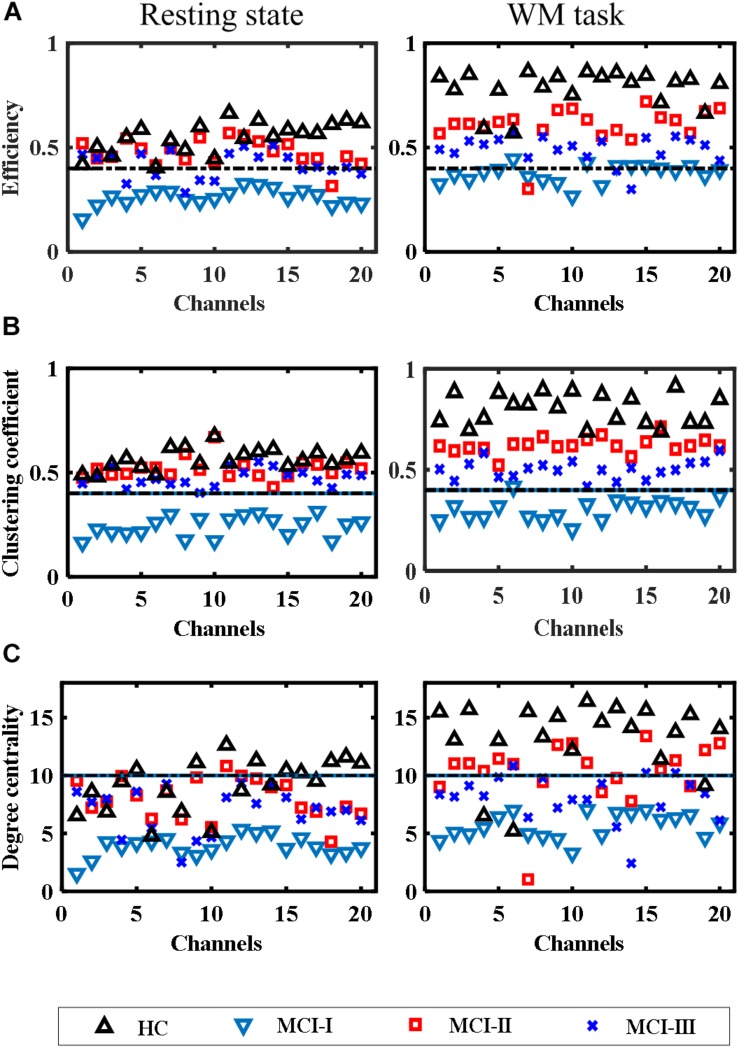
Comparison of nodal metrics for HC, MCI-0, MCI-1, and MCI-2 at different sparsity threshold levels (range: 0.5–0.05–0.9): (A) Efficiency, (B) clustering coefficient, and (C) degree centrality.